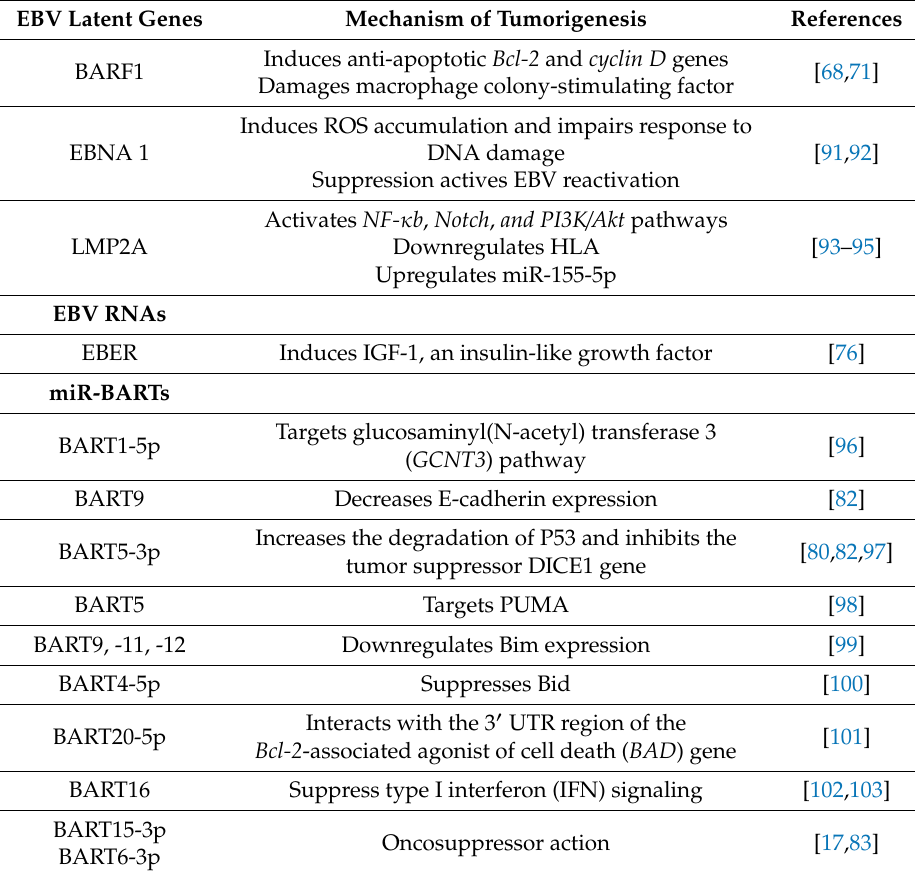
Table 3. Functional roles of some EBV genes and RNAs in